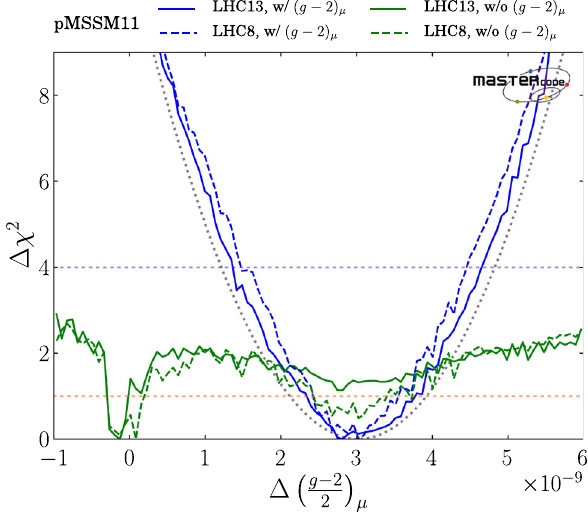
Fig. 7 One-dimensional profile likelihood functions for ( g − 2 ) μ in the pMSSM11, with (blue) and without (green) applying the ( g − 2 ) μ constraint a priori and with (solid) and without (dashed) applying the constraints coming from the LHC run at 13 TeV. Also shown as a dotted line is the experimental constraint [108,109], taking into account the theoretical uncertainty [100–107] within the Standard